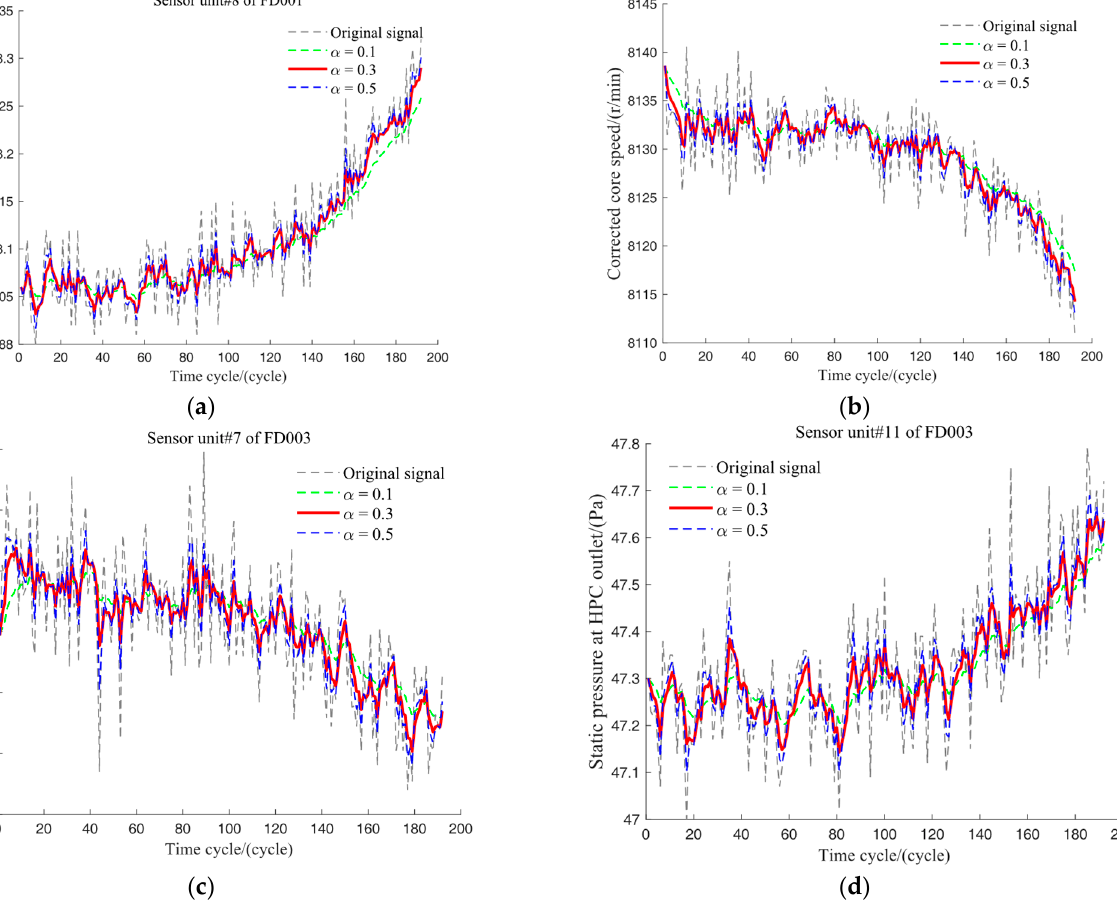
Figure 4. ( a , b ) Performance of ES on sensors #8 and #14 of FD001; ( c , d ) Performance of ES on sensors #7 and #11 of FD003 .